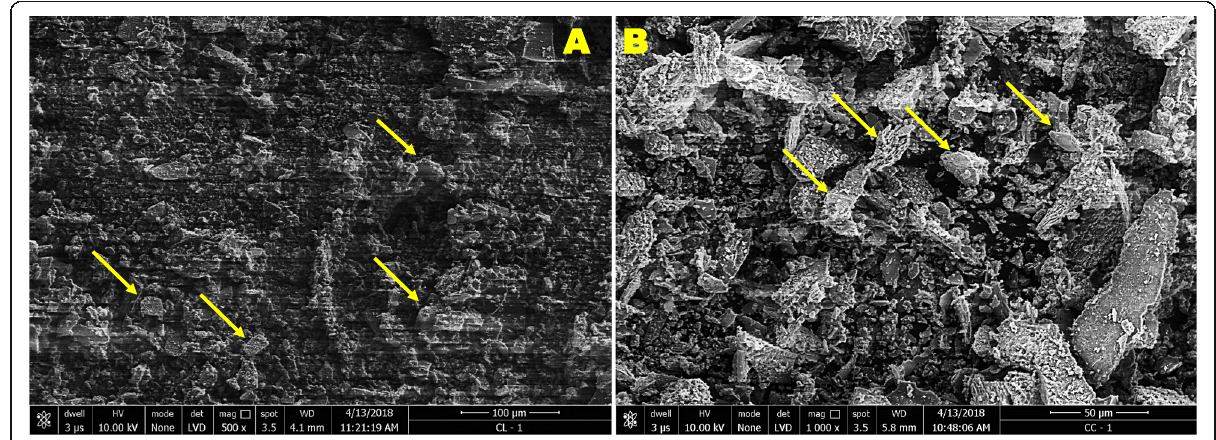
Fig. 6 Scanning electron micrograph of a leaf extract and b callus extract shows the characteristic depth at 100 μ m scale and 50 μ m scale, respectively. The arrow marks indicate the cubic nanoparticles in both leaf and callus